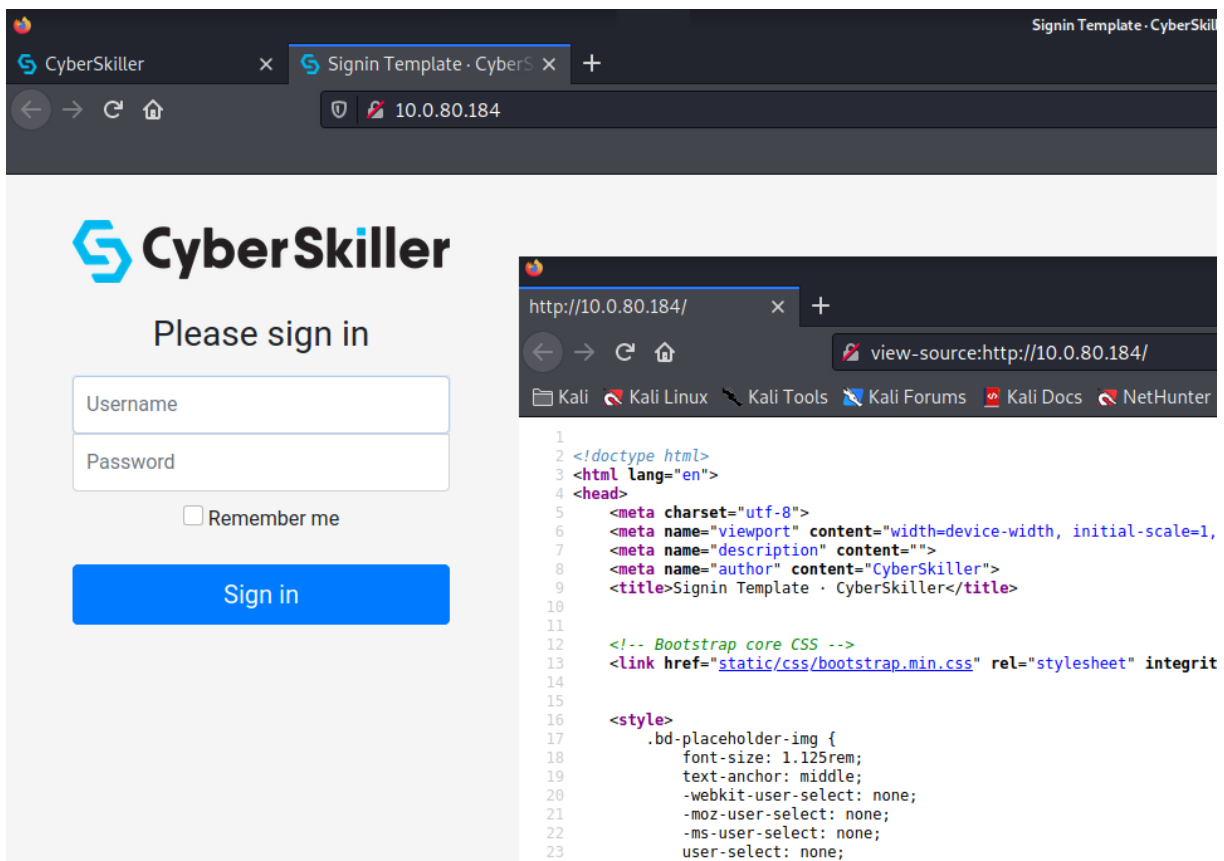
Figure 2. Exercise 2.3: Client-Side Authentication (⋆)